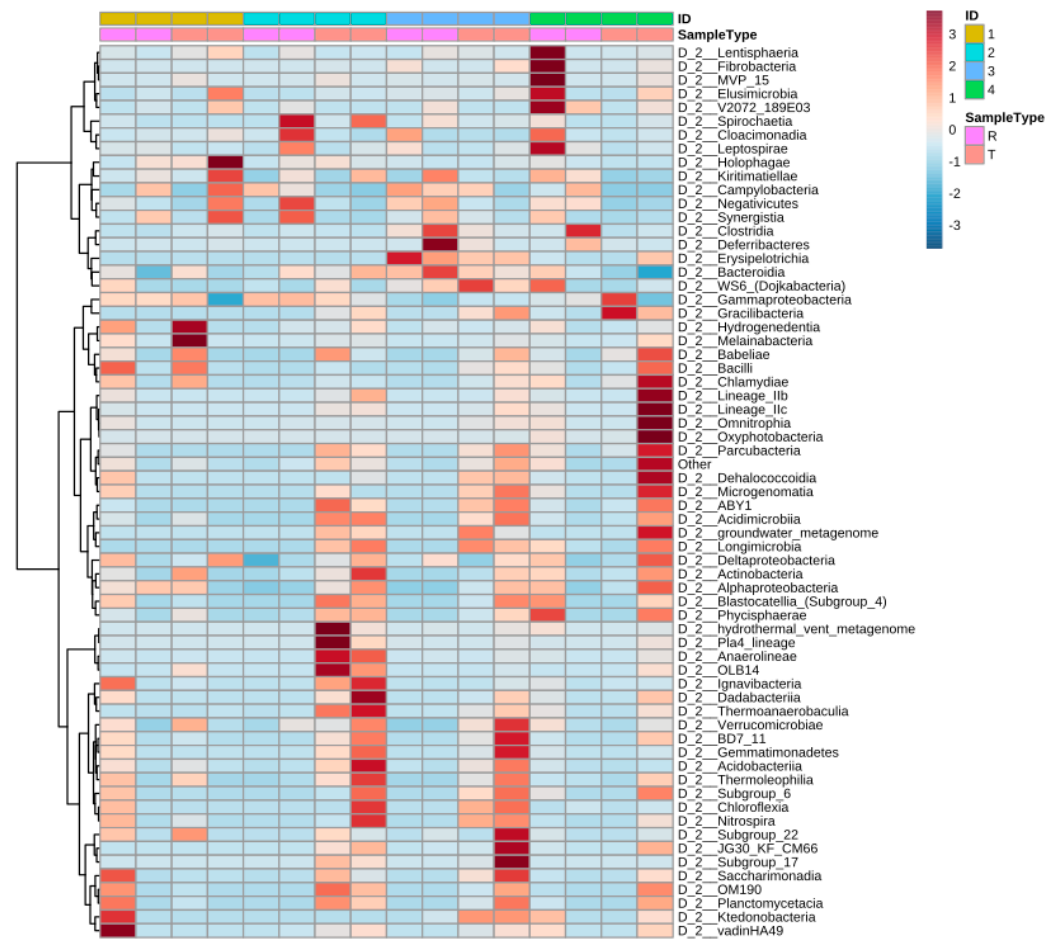
Figure 5. Heat map presenting changes (abundances) of the different classes of bacteria across systems and water type (raw or treated). ID 1,2,3,4 corresponds to CW1, CW2, CW3, CW4, respectively, and R represent raw greywater and T represents treated greywater.